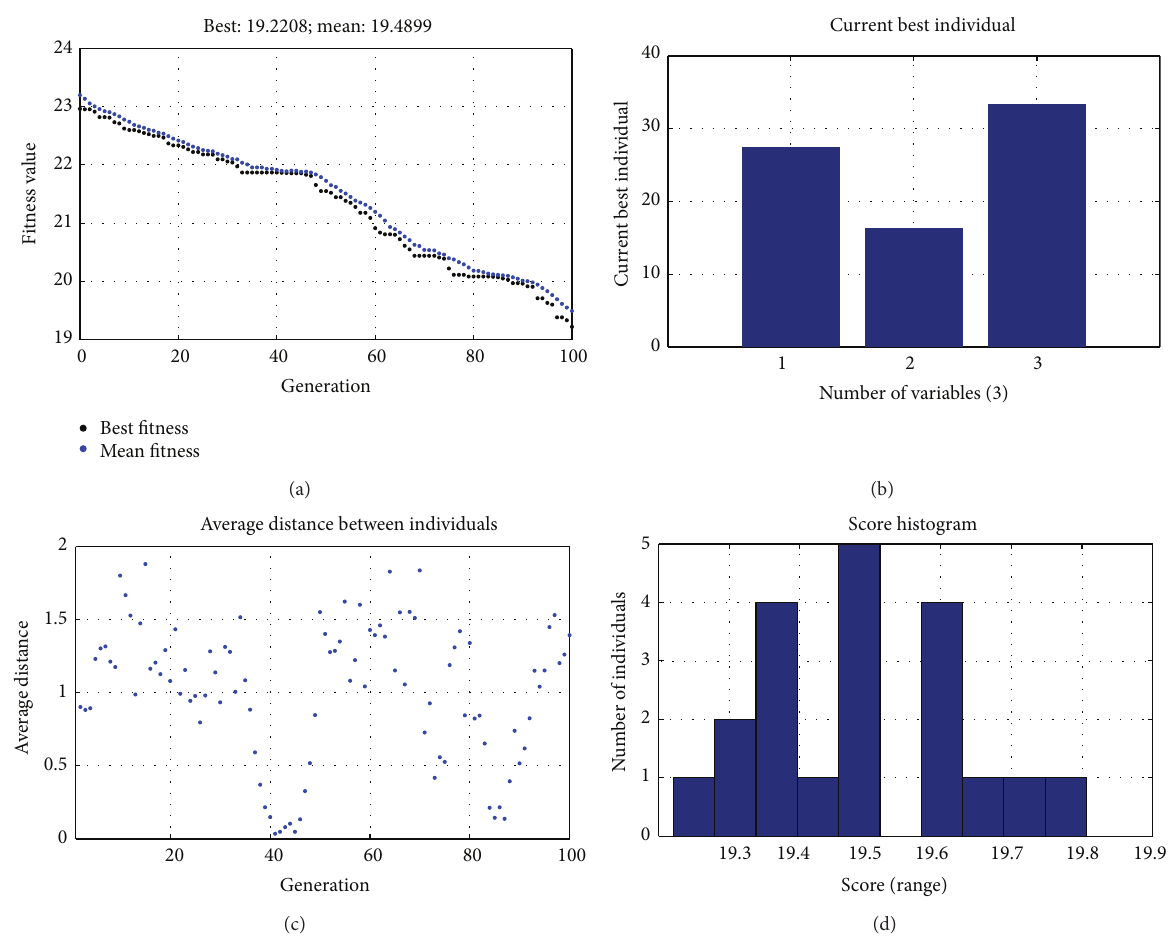
Figure 12: The optimal PV module power at changing the initial population in GA at 6:10AM.